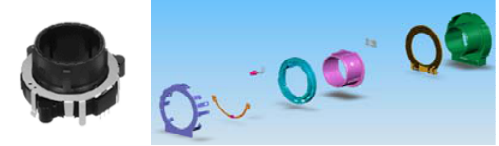
Figure 1. Car audio volume: